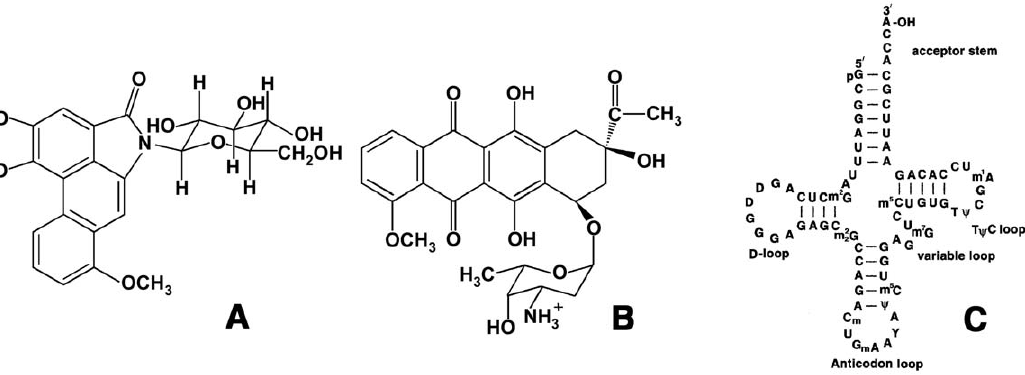
Figure 1. Chemical structures. (A) aristololactam– b -D-glucoside and (B) daunomycin and (C) the cloverleaf structure of yeast tRNA phe .